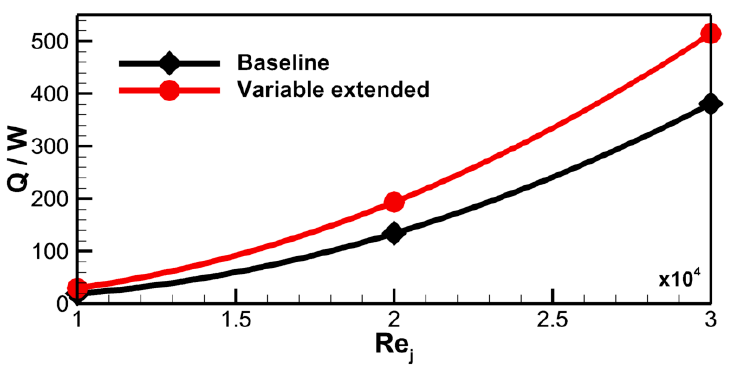
Figure 13. Variation of pumping power with Re j for the baseline and variable extended cases.